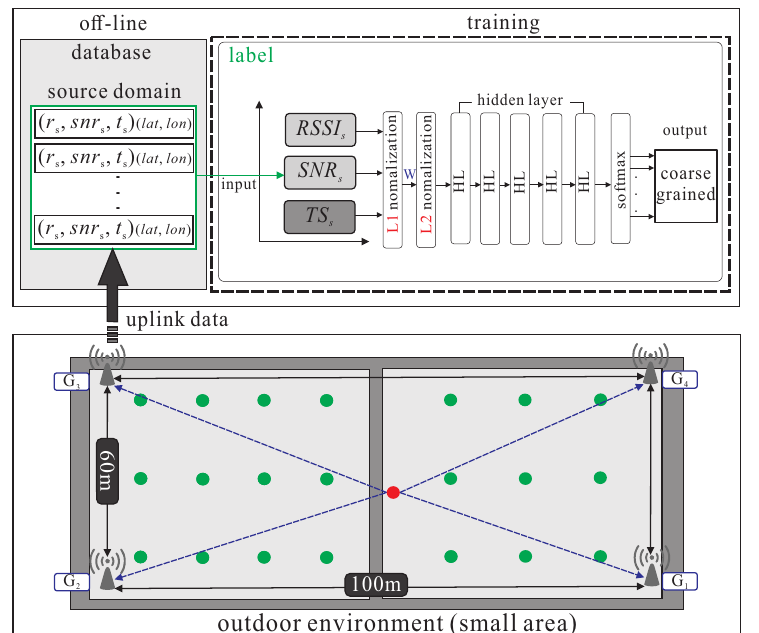
Figure 6. The source domain kernel pre-training phase.